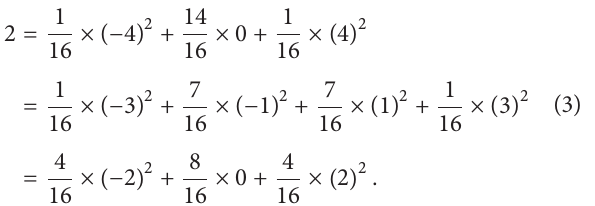
The mask recovery attack outperforms the second-order attack by about two orders of magnitude for SNR ⩾ 0.289